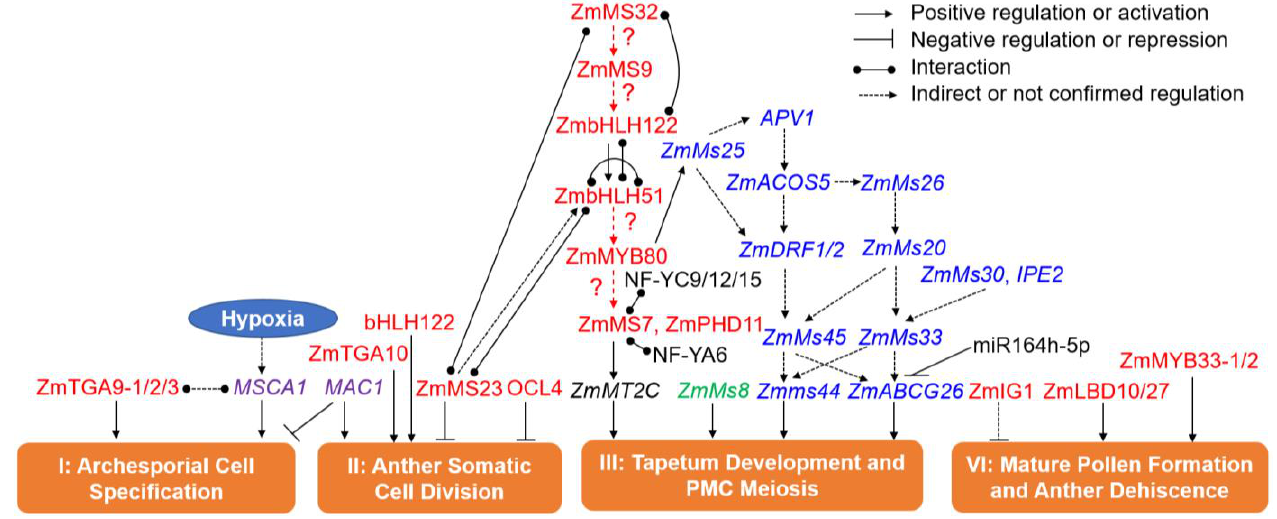
Figure 5. An updated working model for maize GMS genes regulating anther and pollen develop- ment. The GMS genes encoding TFs are marked in red; the GMS genes related to lipid metabolism are represented in blue fonts; the sugar metabolism-related GMS gene is labeled in green; the unclassified GMS genes are in violet; and other important genes or miRNA participating in maize male fertility regulation are in black.